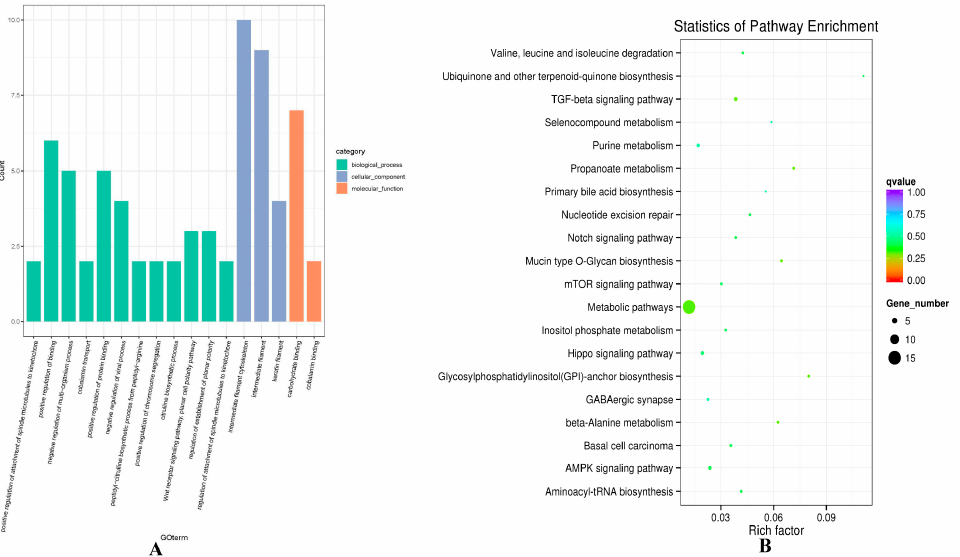
Figure 4. Gene ontology (GO) and Kyoto Encyclopedia of Genes and Genomes (KEGG) analysis of differentially expressed lncRNAs target mRNA through co-location analysis in hair follicle. ( A ) The enrichment GO terms between small waves and straight wool. ( B ) The enrichment pathways between small waves and straight wool.